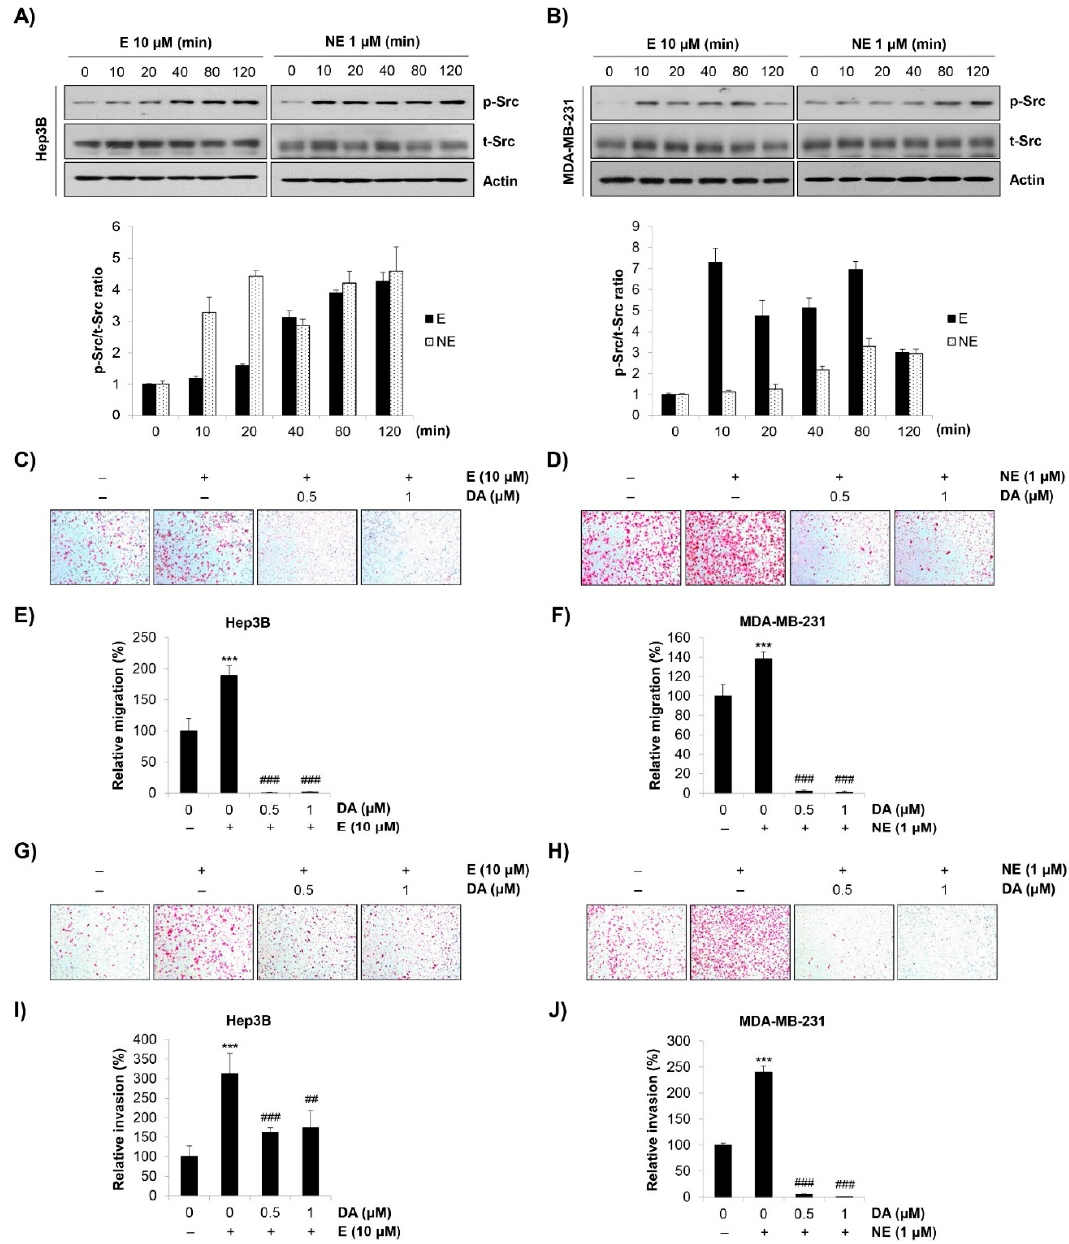
Figure 3. E/NE-induced Src activation stimulates the migration and invasion of Hep3B and MDA-MB-231 cells. ( A , B ) Hep3B human HCC cells ( A ) and MDA-MB-231 human BC cells ( B ) were treated with E (10 µ M) or NE (1 µ M) for the indicated times. Phosphorylated Src and total Src were detected by Western blot analysis. Actin was used as the internal control. The representative images of duplicate experiments are shown (upper). The ratio of phosphorylated/total Src was calculated using ImageJ software after normalization to actin (lower). ( C – J ) Hep3B cells ( C , E , G , I ) and MDA-MB-231 cells ( D , F , H , J ) were seeded in the inserts of transwell plates and co-treated with adrenergic agonists (10 µ M E for Hep3B; 1 µ M NE for MDA-MB-231) and dasatinib (0.5–1 µ M). After 24 h of incubation, the migrated ( C – F ) or invaded ( G – J ) cells were stained and photographed ( × 100 magnification). ( C , D , G , H ) Representative images from triplicate analyses are shown. ( E , F , I , J ) Relative migration ( E , F ) and invasion ( I , J ) was calculated by counting the stained cells. The data are expressed as the mean ± SD of three independent experiments. Significance was determined by the Student’s t -test (*** p < 0.001 vs. untreated controls; ## p < 0.01, ### p < 0.001 vs. E/NE-treated cells). HCC, hepatocellular carcinoma; BC, breast cancer; E, epinephrine; NE, norepinephrine; DA,